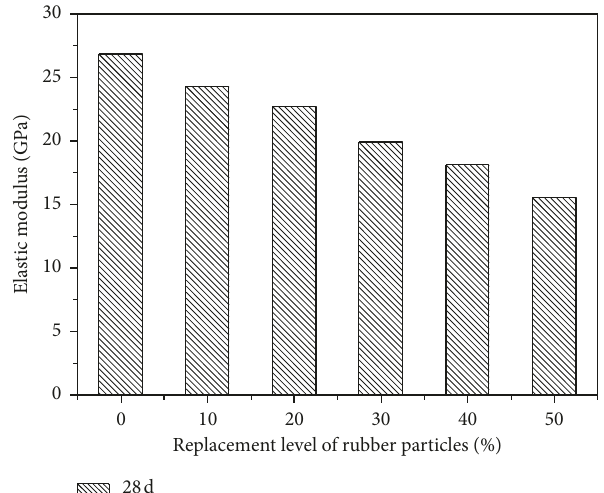
Figure 27: Elastic modulus of SCRLC versus replacement level of rubber particles.